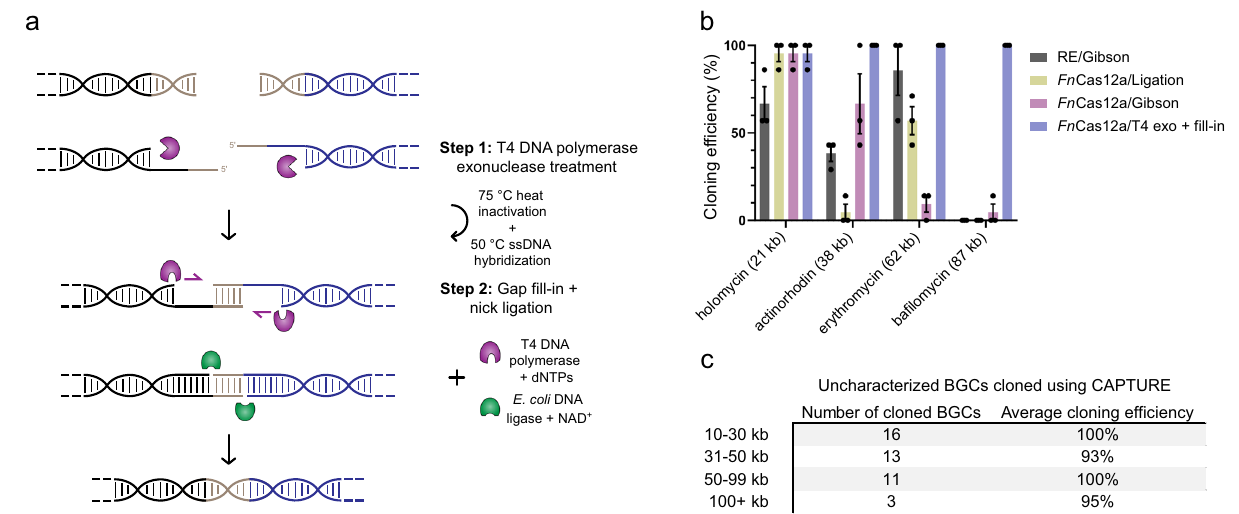
Fig. 2 Characterization of various genomic DNA digestion/DNA assembly combinations in the CAPTURE method. a Schematics of T4 DNA polymerase exo + fi ll-in DNA assembly. In step 1, DNA molecules ends are chewed back by T4 DNA polymerase to create ssDNA overhangs. The reaction mixture ’ s temperature is increased to 75 °C to inactivate T4 DNA polymerase and potentially remove ssDNA secondary structures. Temperature is then decreased to 50 °C to allow for ssDNA overhang hybridization. In step 2, by addition of fresh T4 DNA polymerase, and dNTPs, DNA gaps in the hybridized DNA molecule are fi lled. E. coli DNA ligase is then used to ligate the nicks and produce the fi nal assembly product. b Comparison of different digestion/DNA assembly combinations in cloning four high GC-content BGCs from Actinomycetes. The Fn Cas12a/T4 exo + fi ll-in strategy showed ~100% cloning ef fi ciency for all four target BGCs. RE: restriction enzymes. For each cloning experiment, at least seven colonies were selected and the puri fi ed plasmids from each colony were analyzed by restriction digestion. The cloning ef fi ciencies were calculated as the ratio of correct colonies to the total number of checked colonies. Each experiment was performed in three biological replicates and data are presented as mean values ± standard error (SEM). c Summary of results for cloning uncharacterized BGCs using CAPTURE. BGCs ranging from 10 to 113 kb can be robustly cloned using the CAPTURE method at close to 100% ef fi ciency regardless of their GC-content. Source data are provided as a Source Data fi